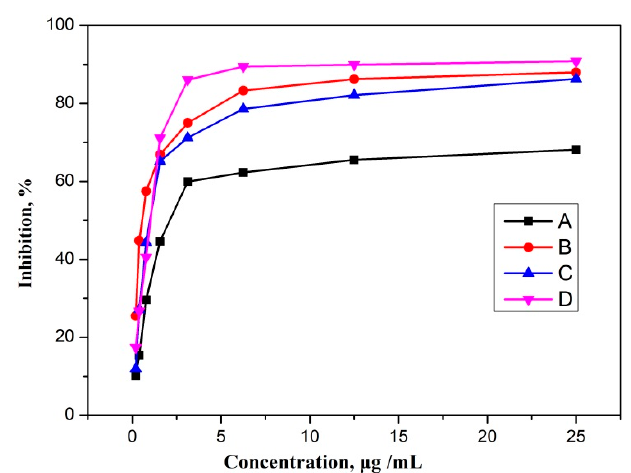
Figure 6. Dose response curve of inhibition of PTP-1B enzyme for total triterpenoids fraction before purification ( A ), total triterpenoids fraction after purification ( B ), ursolic acid ( C ), and oleanolic acid ( D ).